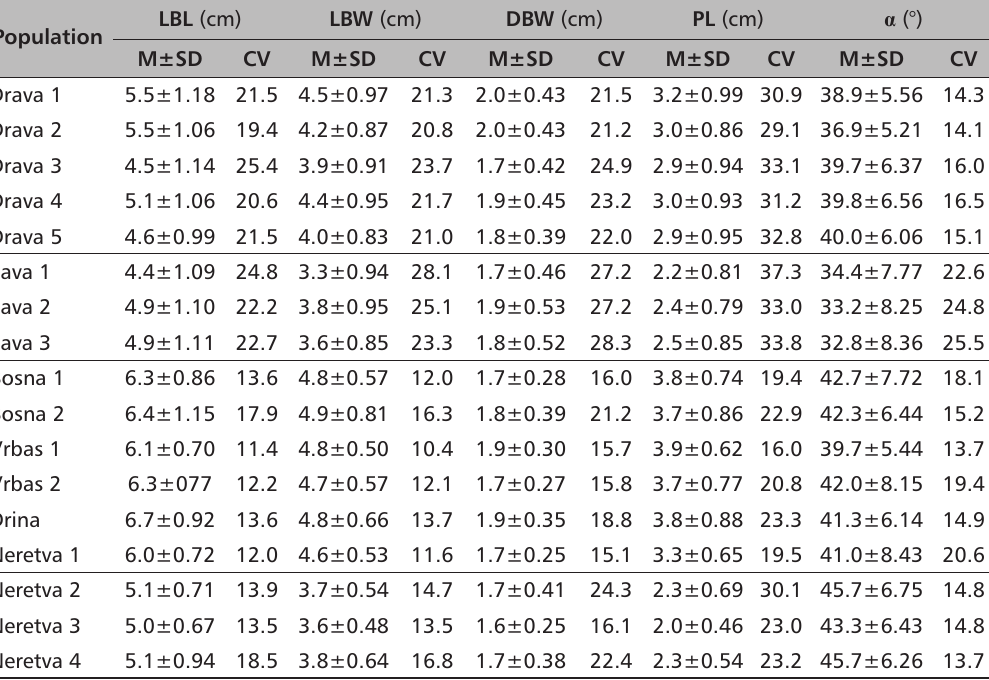
taBle 2. Descriptive statistics of the measured morphological traits at the population level